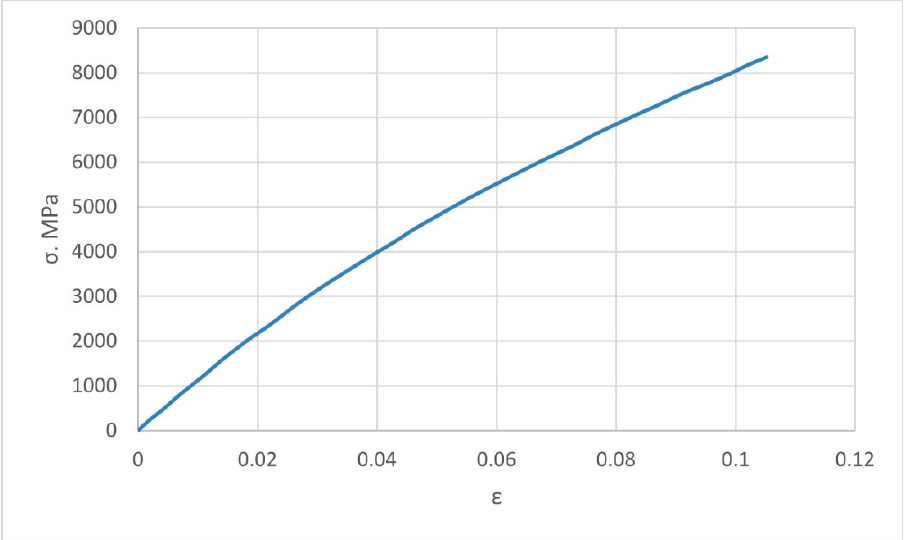
Figure 4. The true stress–strain curve for finely dispersed coke with zero porosity.